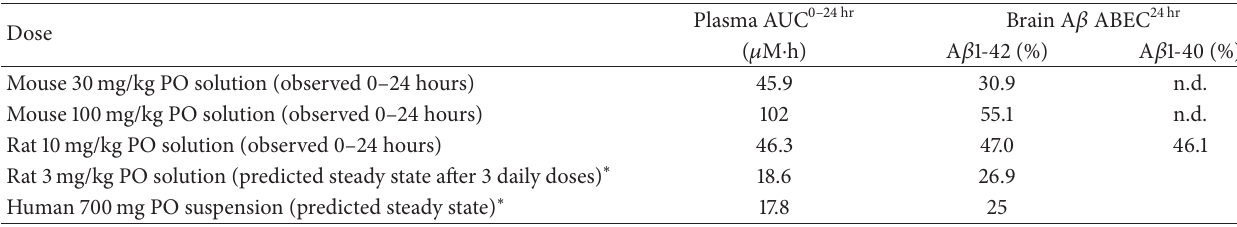
Table 3: Relationship between dose, plasma AUC, and A 𝛽